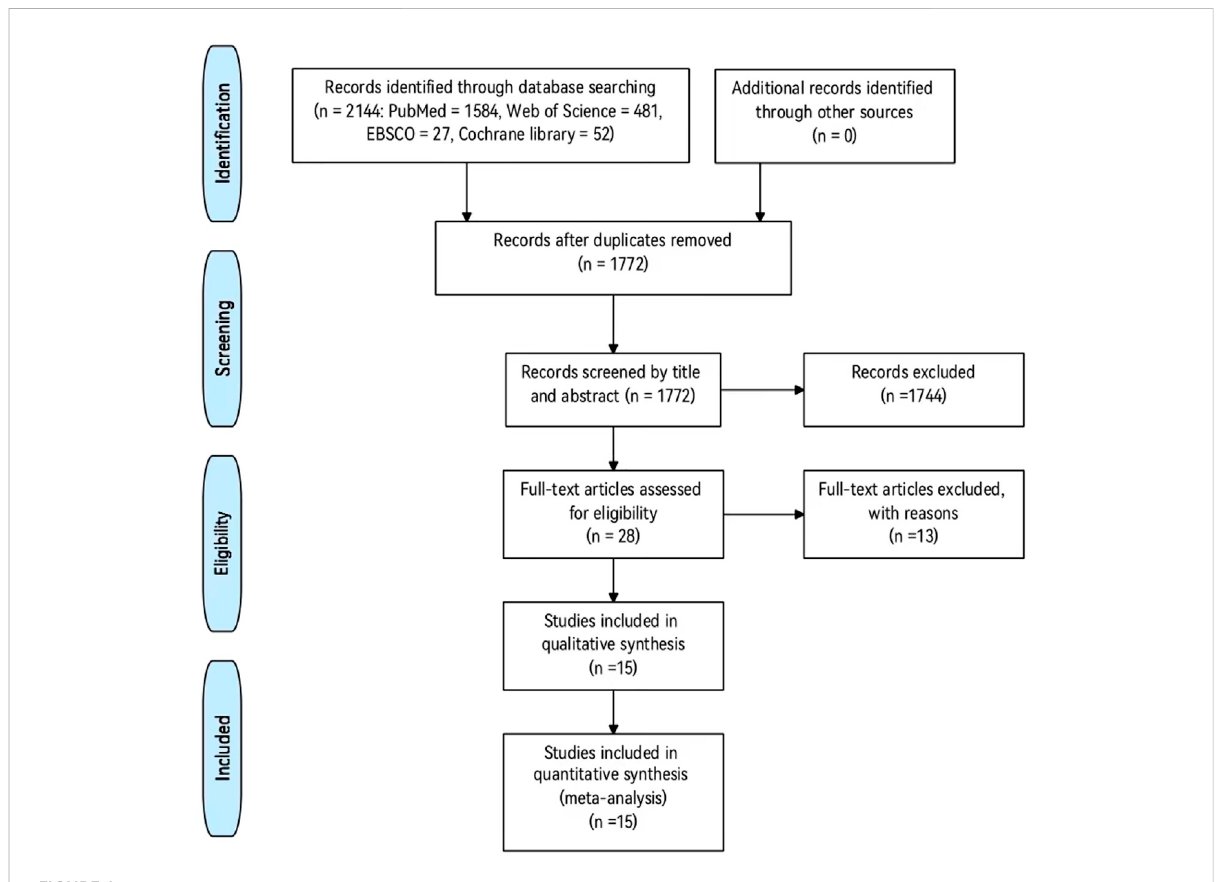
FIGURE 1 The fl owchart of the search